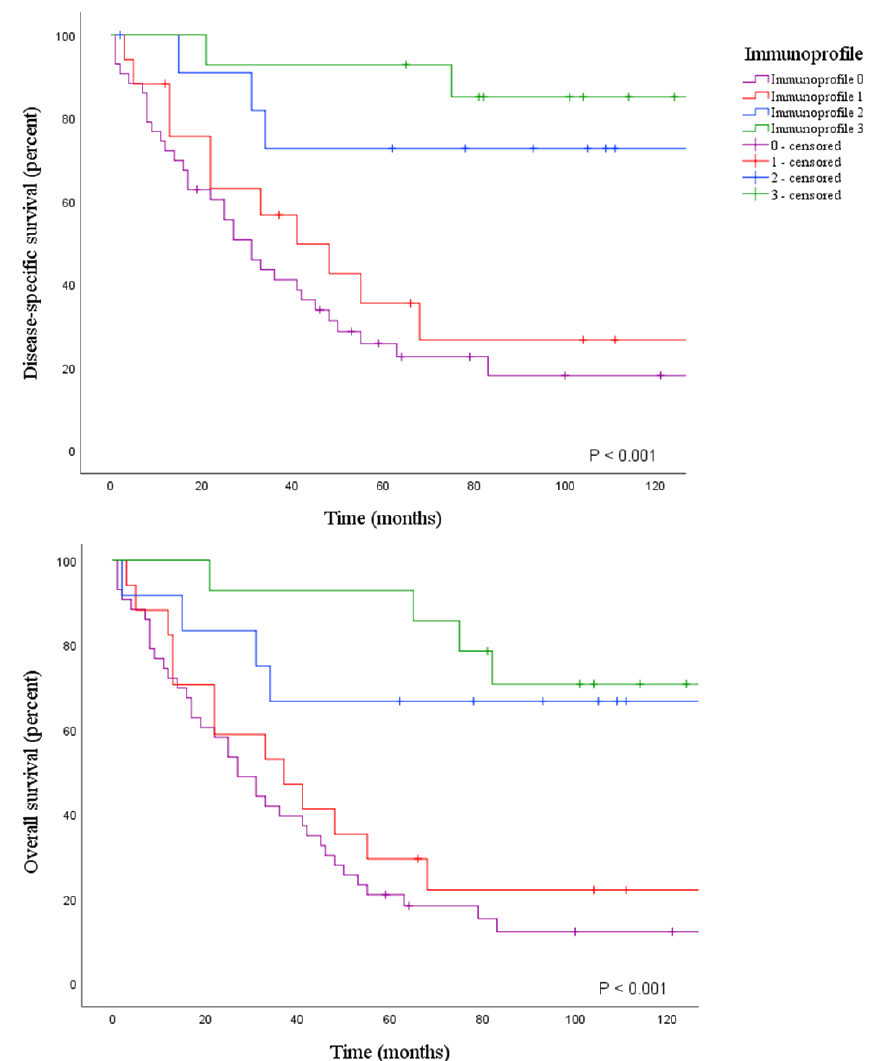
Figure 1. Disease-specific and overall survivals according to Figure 1. Disease ‐ specific and overall survivals according to Immunoprofile.